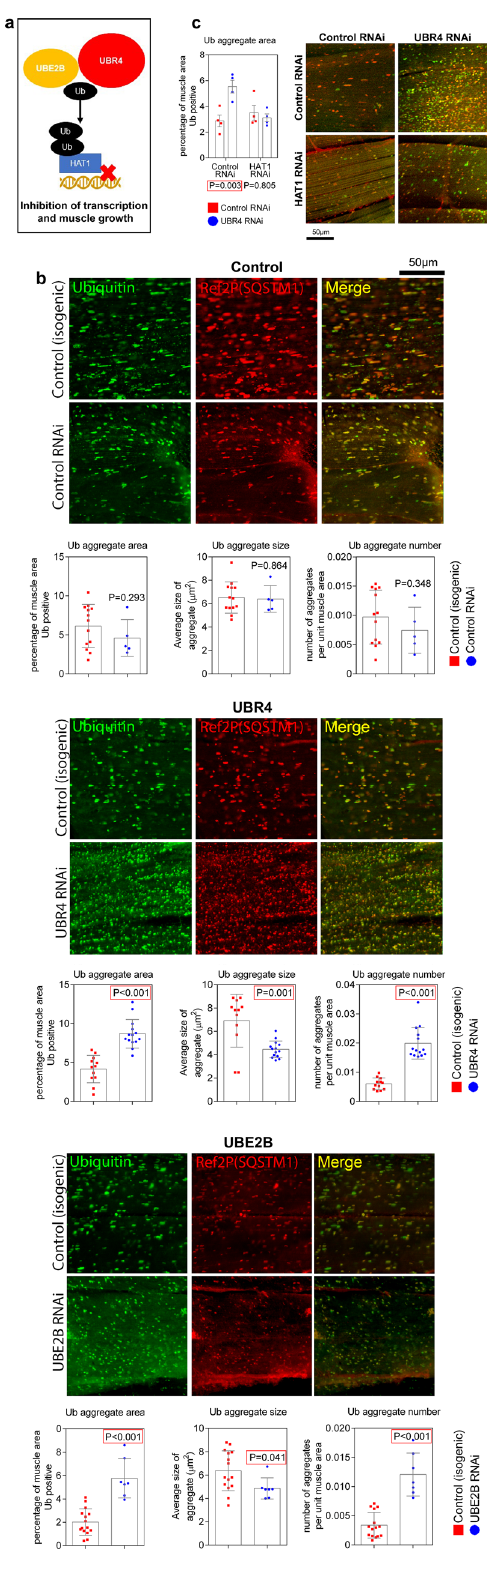
and degradation of its substrate HAT1 16 , which is necessary for inducing myo fi ber hypertrophy (Fig. 6a). Immunostaining of skeletal muscle from 8-week-old fl ies indicates that UBR4 RNAi increases the total area and number of SQSTM1-positive aggregates of poly-ubiquitinated proteins, though reduces the individual aggregate size (Fig. 6b). Therefore, UBR4 is necessary